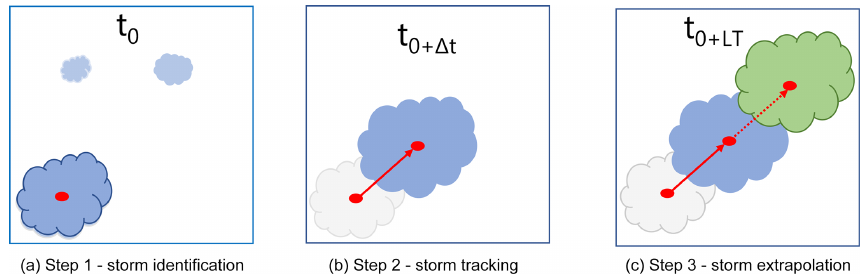
Figure 1. The main steps of an object-based radar nowcast. Blue indicates the current state of the storm at any time t , grey indicates the past states of the storm (at t 0 + (cid:49)t ), and green indicates the future states of the storm ( t 0 + LT ) (Shehu,